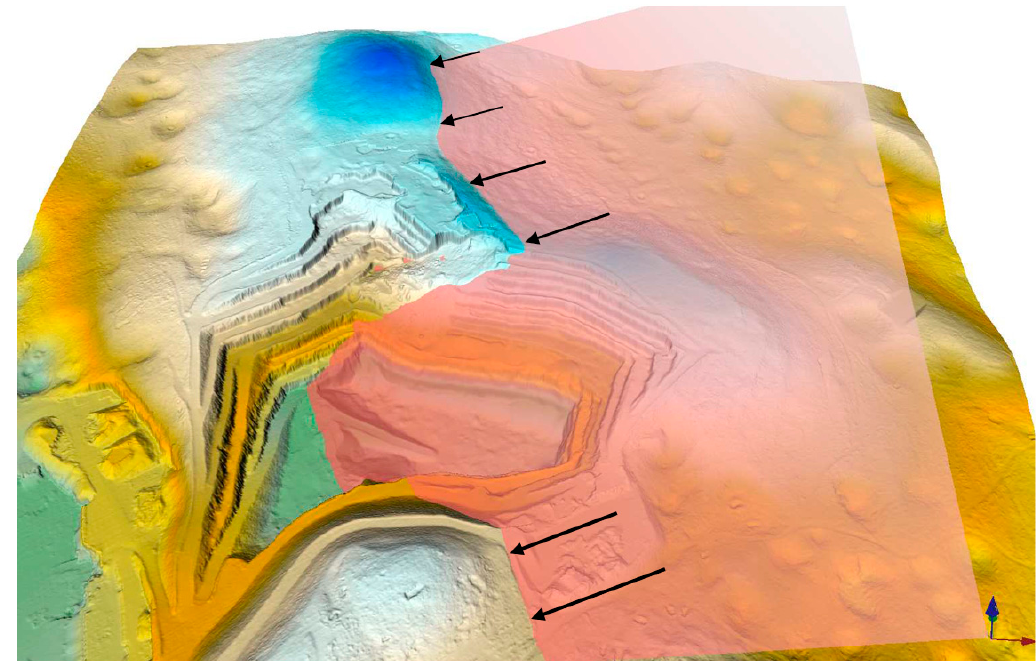
Figure 7. The Laže 1 quarry (a view to the north). Using the mapping data, the plane of the main crack (red surface) was constructed and put into a digital relief model. This gave us a spatially visible and determinable projection of the still ‐ unexcavated areas and the entire surface (arrows). The spatial orientation of a sliding surface is defined by the direction of the normal vector, which here was [ − 0.324150, − 0.150404, 0.933973]. From this, the slope (21°) and azimuth (245°) of the sliding